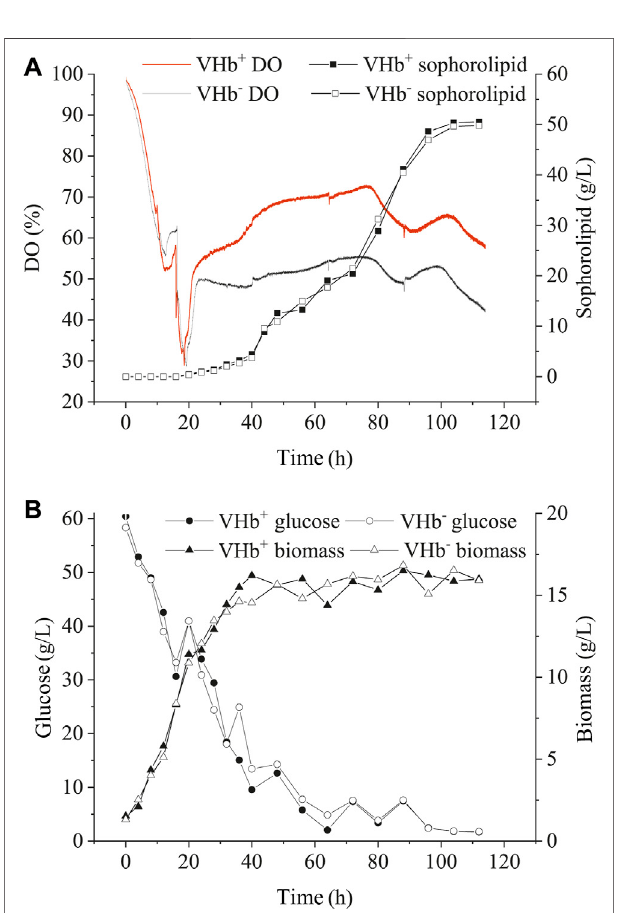
FIGURE 4 | Effects of VHb expression on DO content and SLs production (A) , residual sugar and biomass (B) under oxygen-rich conditions.